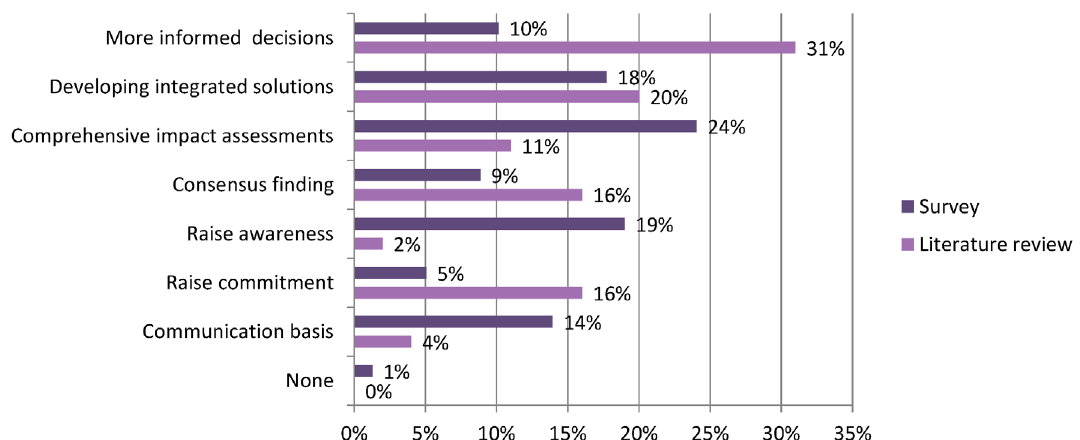
Figure 5: Benefits of using the ES approach in participatory processes as perceived by survey re- spondents (percentage of positive agreements, 79 answers) and based on mentions in literature (45